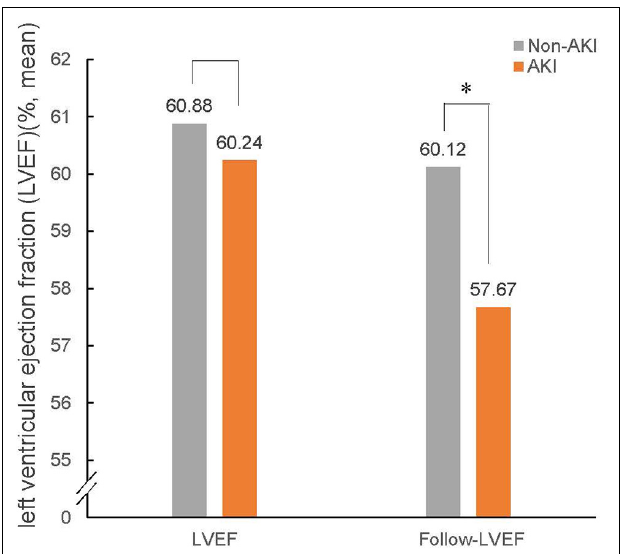
FIGURE 3 | LVEF at baseline and follow-up in patients with non-AKI and AKI. The bar graphs show LVEF at baseline and follow-up in patients with non-AKI (gray) and AKI (orange). AKI, acute kidney injury; LVEF, left ventricular ejection fraction. ∗ P < 0.05.